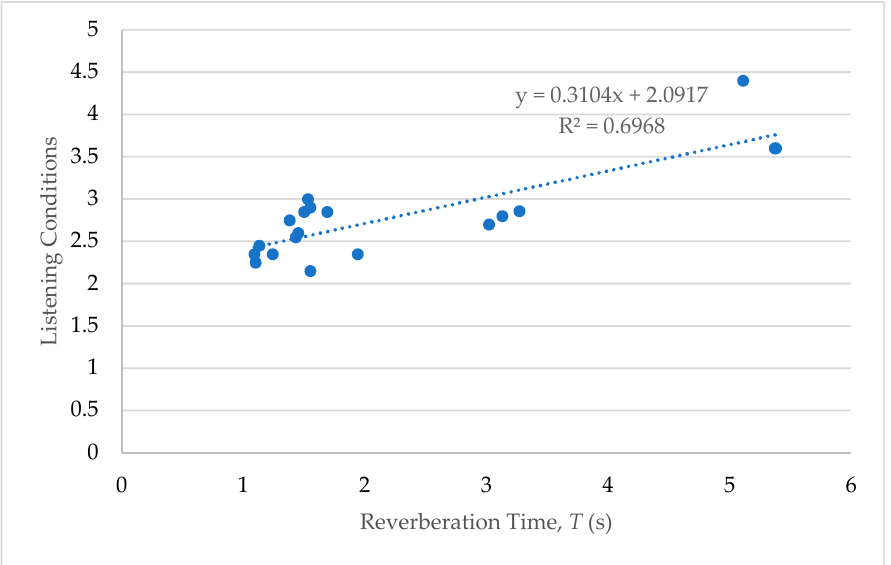
Figure 12. Relationship between reverberation time and subjective rating of listening conditions.